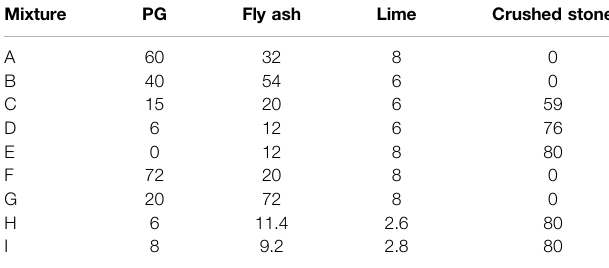
FIGURE 2 | Relationship between curing time and compression rebound